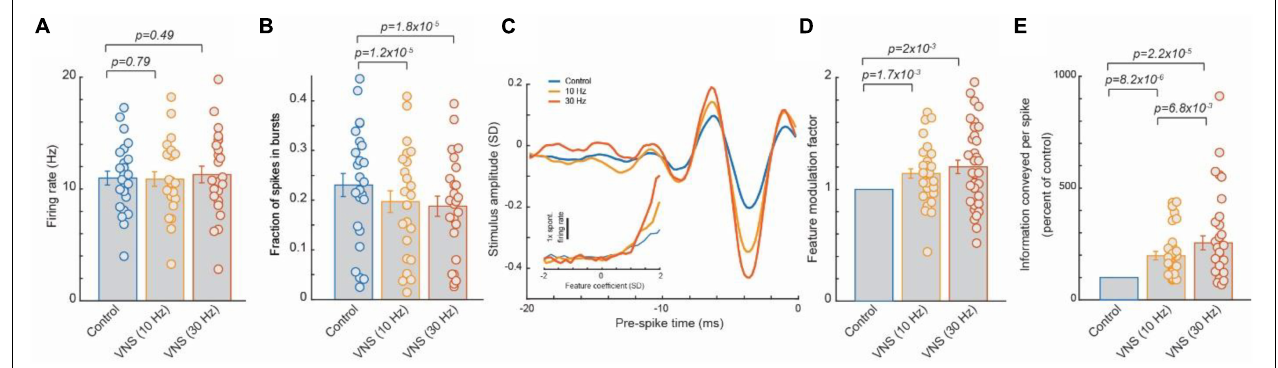
FIGURE 1 | Tonic VNS suppressed burst spiking of thalamocortical neurons and increased the selectivity of their response to the specific stimulus feature they encode, leading to a greater amount of sensory-related information transmitted. (A) VNS did not significantly alter firing rate of ventral posteromedial nucleus (VPm) neurons responding to white gaussian noise whisker (WGN) stimulation. (B) VNS reduced likelihood of VPm burst spikes, multiple successive spikes with a short inter-spike-intervals ( ∼ 4 ms or less) commonly occurring after an extended period of quiescence ( ∼ 100 ms) due to calcium t-channel current. (C,D) The amplitude of the specific kinetic feature(s) (i.e., whisker deflection) each VPm neuron was selective for was much larger when recovered during VNS, indicating VNS increased selectivity of response. (E) Enhanced feature selectivity of VPm neurons during VNS results in a significant increase in amount of the sensory-related information transmitted per spike. Adopted from Rodenkirch and Wang